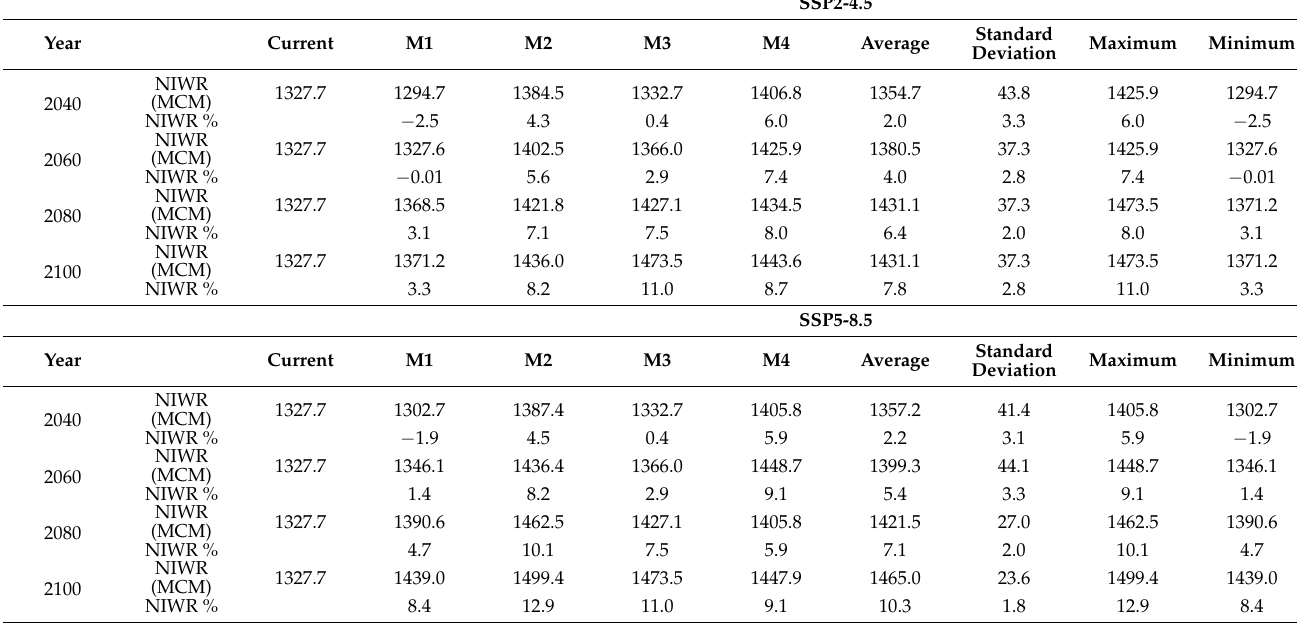
Table 7. Predicted net irrigation water requirements (NIWR) values in million m 3 (MCM) and changes (%) compared to current obtained from four climate models for 2040, 2060, 2080, and 2100 under SSP2-4.5 and SSP5-8.5 emission scenarios and current condition (2020) for Al Quassim region.